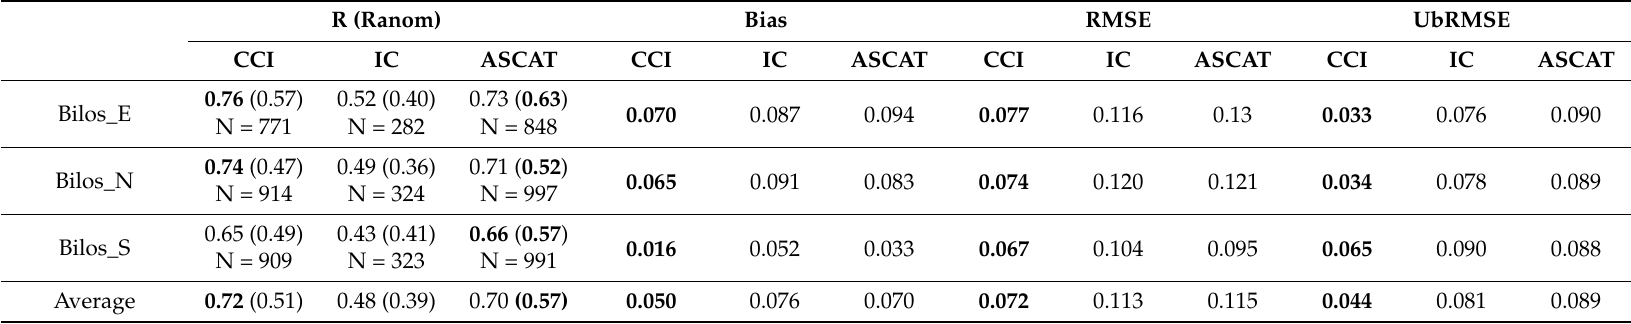
Table 6. Pearson correlation (R), Bias, RMSE, and ubRMSE calculated between SMOS-IC, ASCAT, and CCI SM retrievals and the Bilos in situ measurements using all